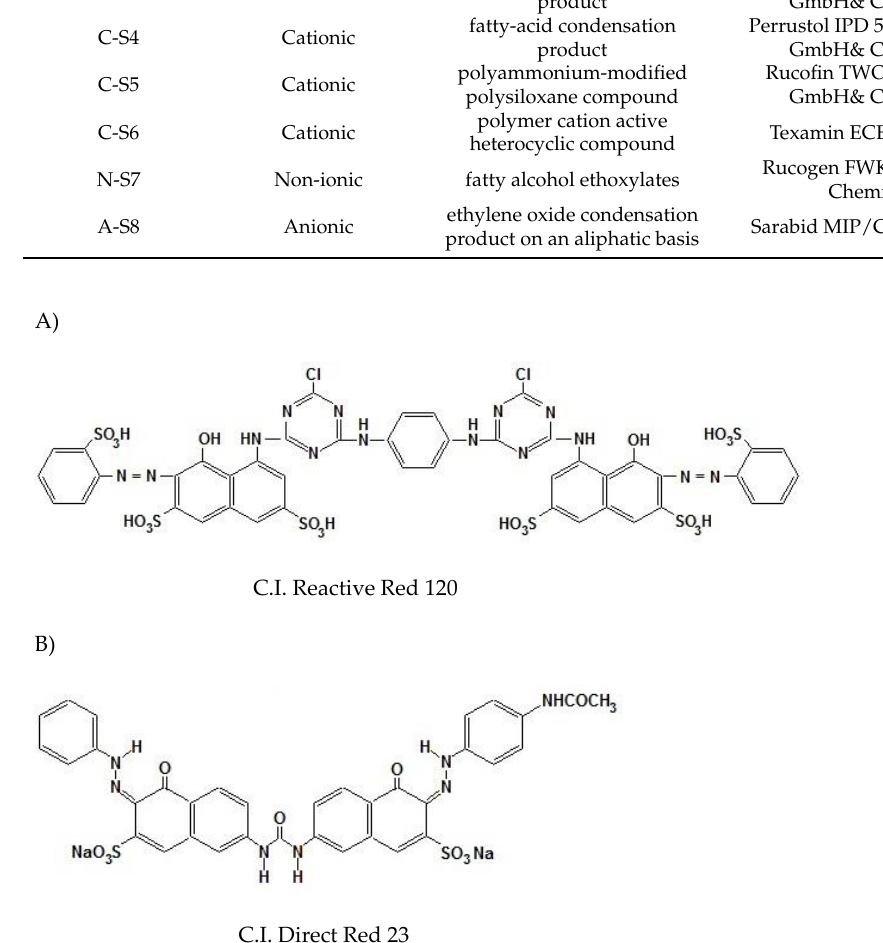
Figure 1. Chemical structures of the tested dyes: ( A ) Reactive Red 120, ( B ) Direct Red 23. Table 1. Detergents used in the experiments.